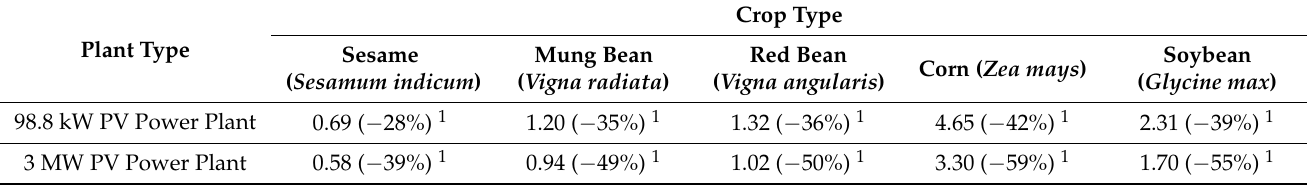
Table 9. Estimated grain yields (Mg/ha) of all five crops.